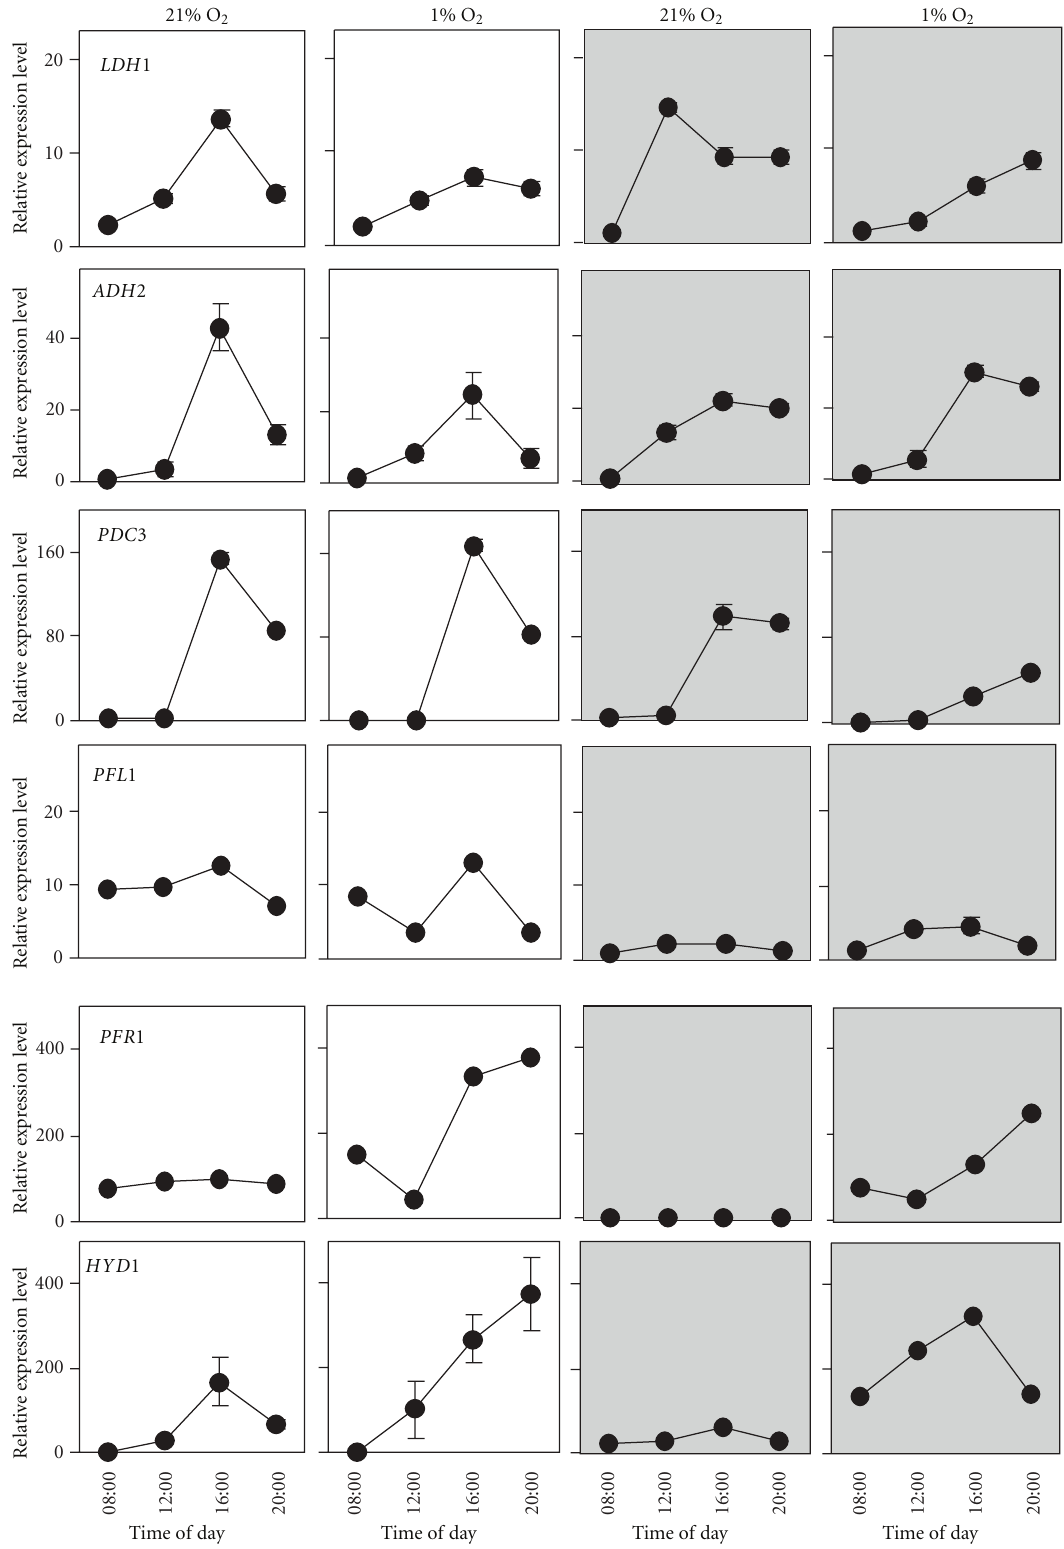
Figure 3: The combined e ff ect of 21% versus 1% O 2 influxation in the culture media and light versus dark on the expression of LDH1, ADH2, PDC3, PFL1, and PFR1 followed a 12-hour period starting at 8 :00 in the morning, with samples taken every 4 hours. Relative expression levels were measured by real-time reverse-transcription polymerase chain reaction (qPCR) (1 = the lowest value of expression measured in the 4 conditions). Data are mean ± SD, n = 3 replicates. When not shown, the error bars were smaller than the